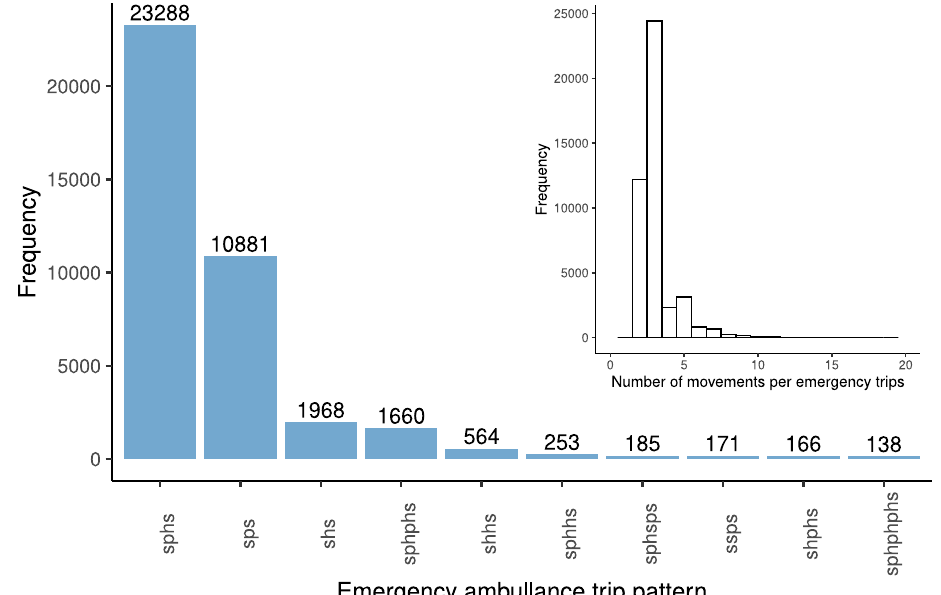
Figure 6. Frequencies of emergency ambulance trip patterns. The characters encode the visit of an ambulance station (“s”), hospital (“h”), and patient “p”. The inset shows the frequencies of movement counts that constitute a trip. The empirical probability of observing a trip of a given pattern can be calculated by dividing the frequency by the total number of trips,